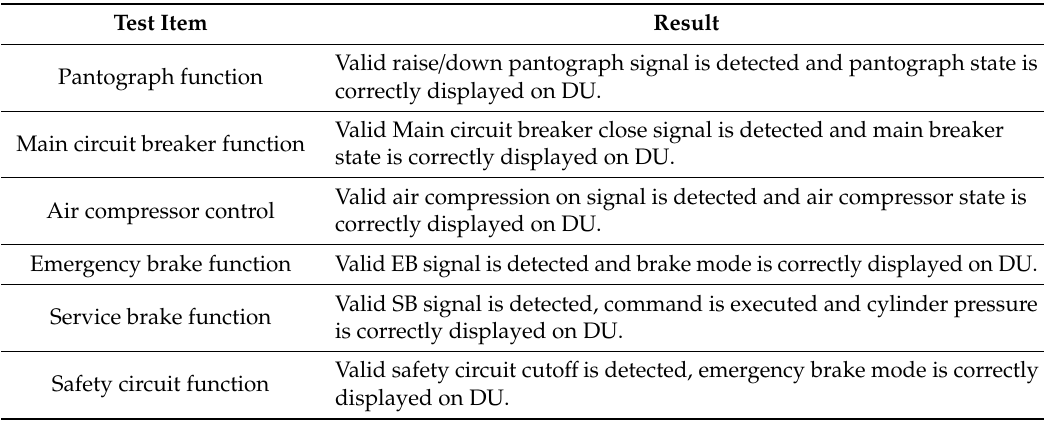
Table 3. Functional test